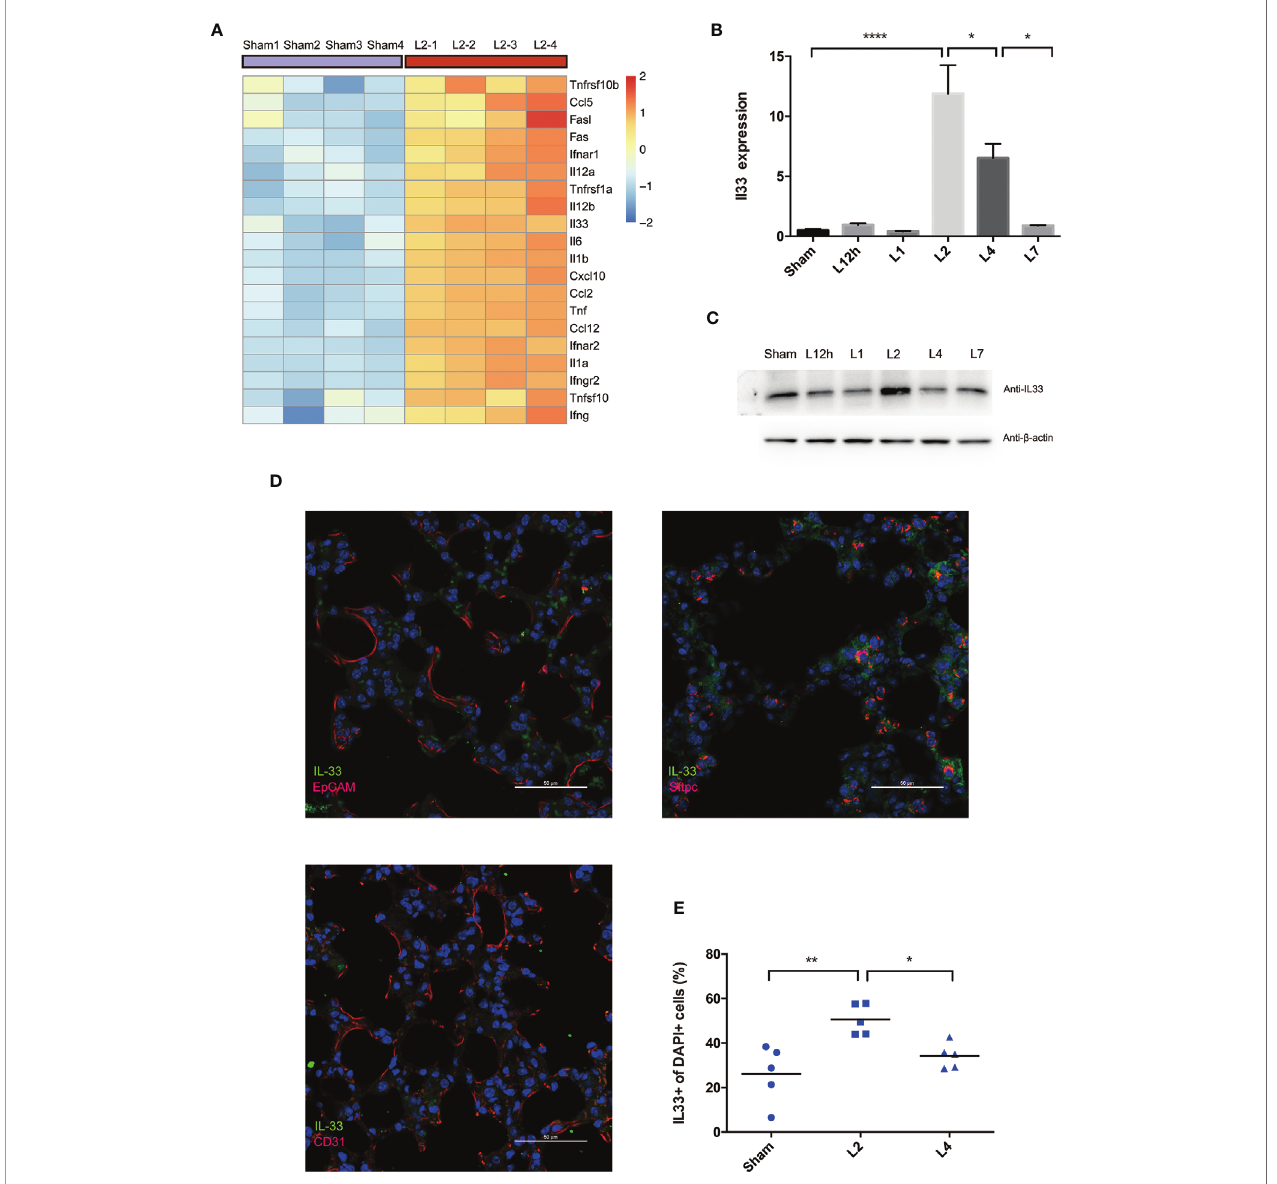
FIGURE 4 | LPS-induced ARDS triggers the release of IL-33 from the in fl amed lung. (A) Heat map showing the top 20 most upregulated in fl ammatory cytokines and chemokines in LPS-induced ARDS, identi fi ed by mouse RNA-seq analysis. Sham group mice received intratracheal saline instillation. n = 4 mice per group. (B, C) IL-33 dynamic variation within days after LPS-induced ARDS. (B) Il33 transcripts in the lung were quanti fi ed by PCR. (C) IL-33 protein was estimated by Western blotting. n = 6 mice per group. (D) Colocalization of IL-33+ cells (epithelial cells, AEC2s, and endothelial cells) in the lung was explored by immuno fl uorescence microscopy. Scale bars represent 50 m m. (E) Increase in IL33+ cells upon lung injury. The fraction of IL33+ nuclei (DAPI+ structures) was measured as described in the methods. n = 5 mice per group. For all panels: mean ± S.D. *p ≤ 0.05; **p ≤ 0.01; and ****p ≤ 0.0001 for one-way analysis of variance with the Bonferroni post hoc test for multiple t-tests. A value of p < 0.05 was considered statistically signi fi